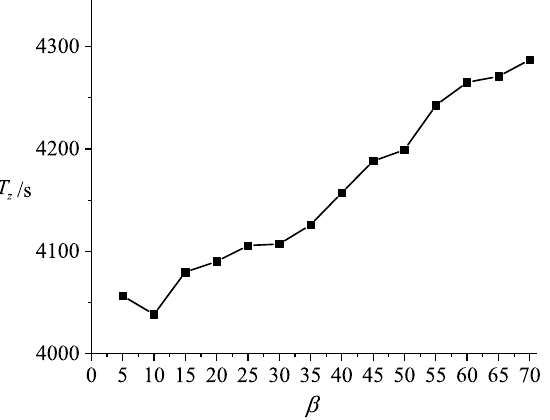
Figure 11. Variation curve of total time T z and heuristic pheromone weight β